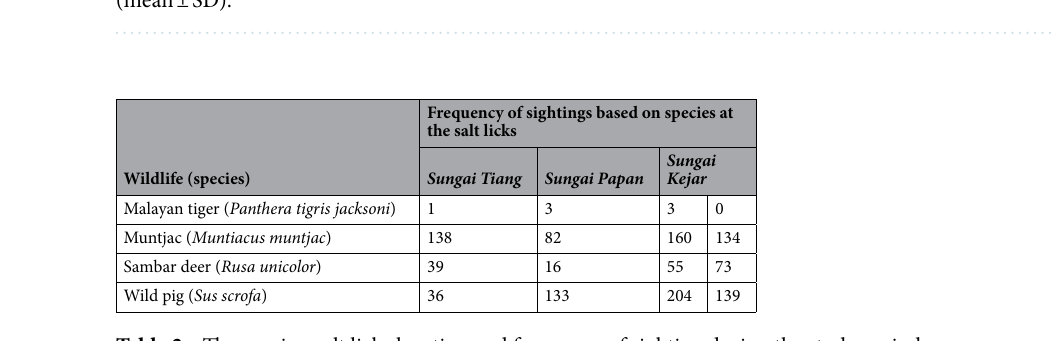
Table 2. The species, salt licks location and frequency of sighting during the study period.